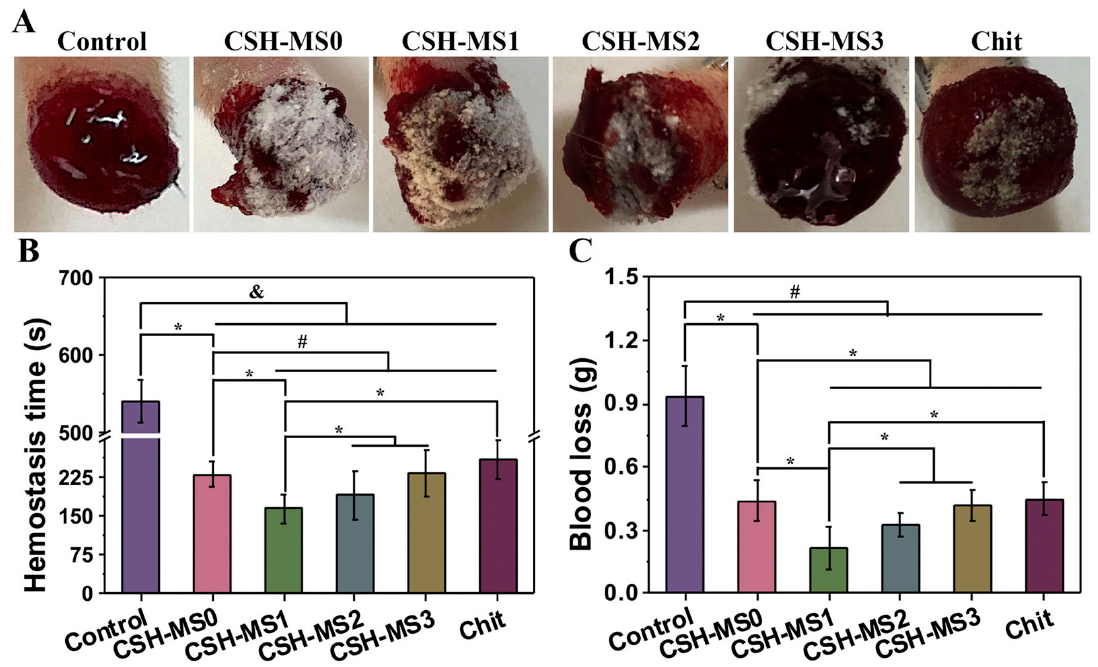
Figure 11. Hemostatic activity of cationic superabsorbent hydrogel coordinated by mesoporous silica (CSH-MS). ( A ) In vivo hemostatic performance. ( B ) Hemostasis time in different groups of materials applied to rat tail truncation model. ( C ) Blood loss in rat tail truncation model. *, p < 0.05; #, p < 0.01; &, p < 0.001 [101].